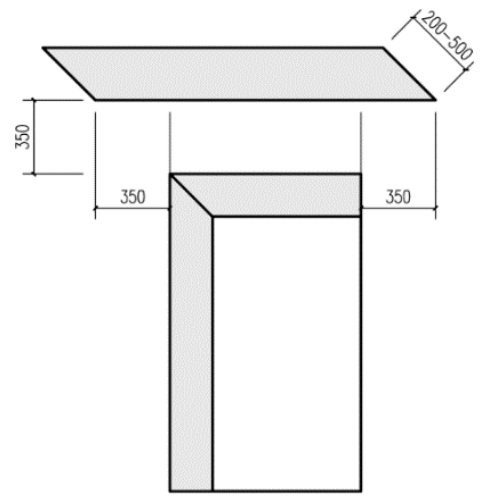
Figure. 8 The opening shading parameters of Xiashanhu houses (unit: